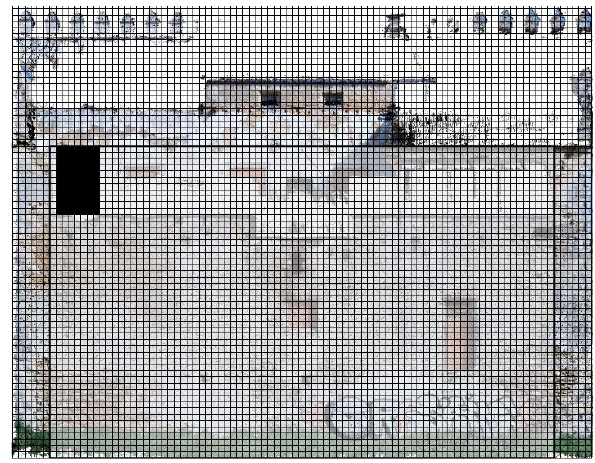
Figure 4. A 22cmx22cm grid overlaid to the front view of the main façade.